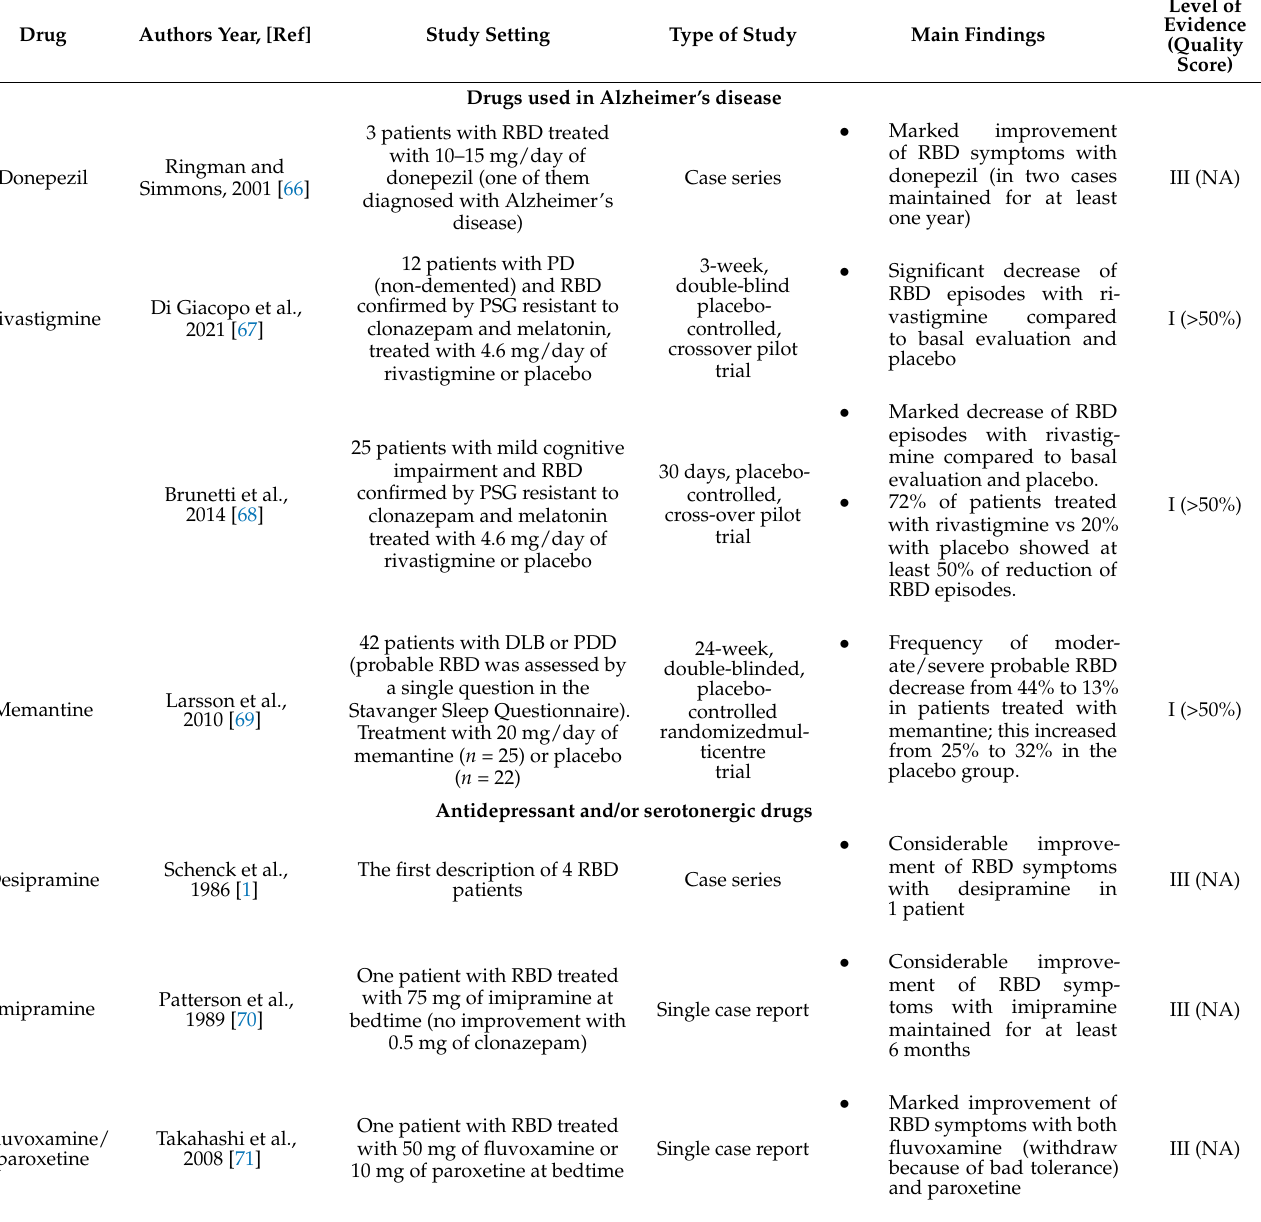
Table 6. Description of the effect of other drugs in the treatment of